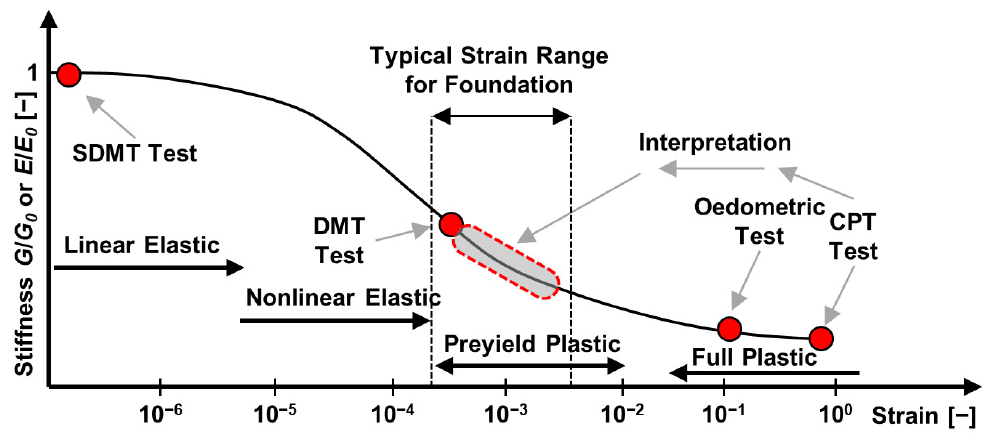
Figure 2. The soil stiffness degradation curve.